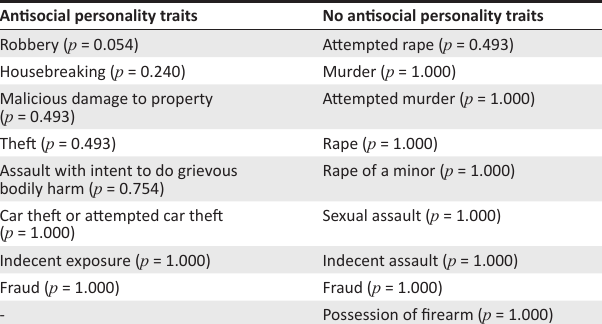
TABLE 1: Prevalence of the presence or absence of antisocial personality traits in patients of the two groups according to offence committed. Antisocial personality traits